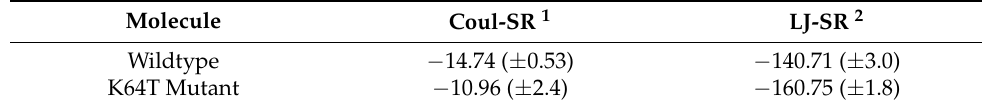
Table 4. Interaction energy components for CQ–PfCRT complex .